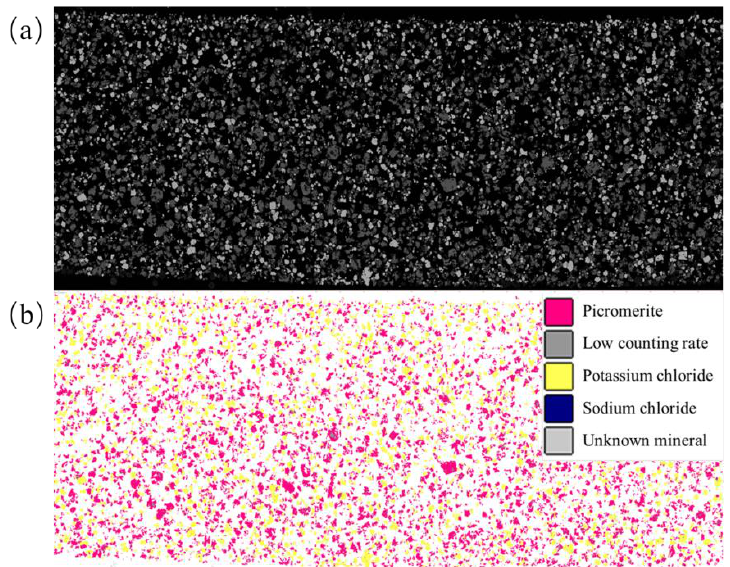
Figure 3. MLA test diagram of MP sample, ( a ) is the original image, and ( b ) is the processed image: the red area is picromerite, the dark gray area is low counting rate, the yellow area is potassium chloride, the blue area is sodium chloride, and light gray area is an unknown